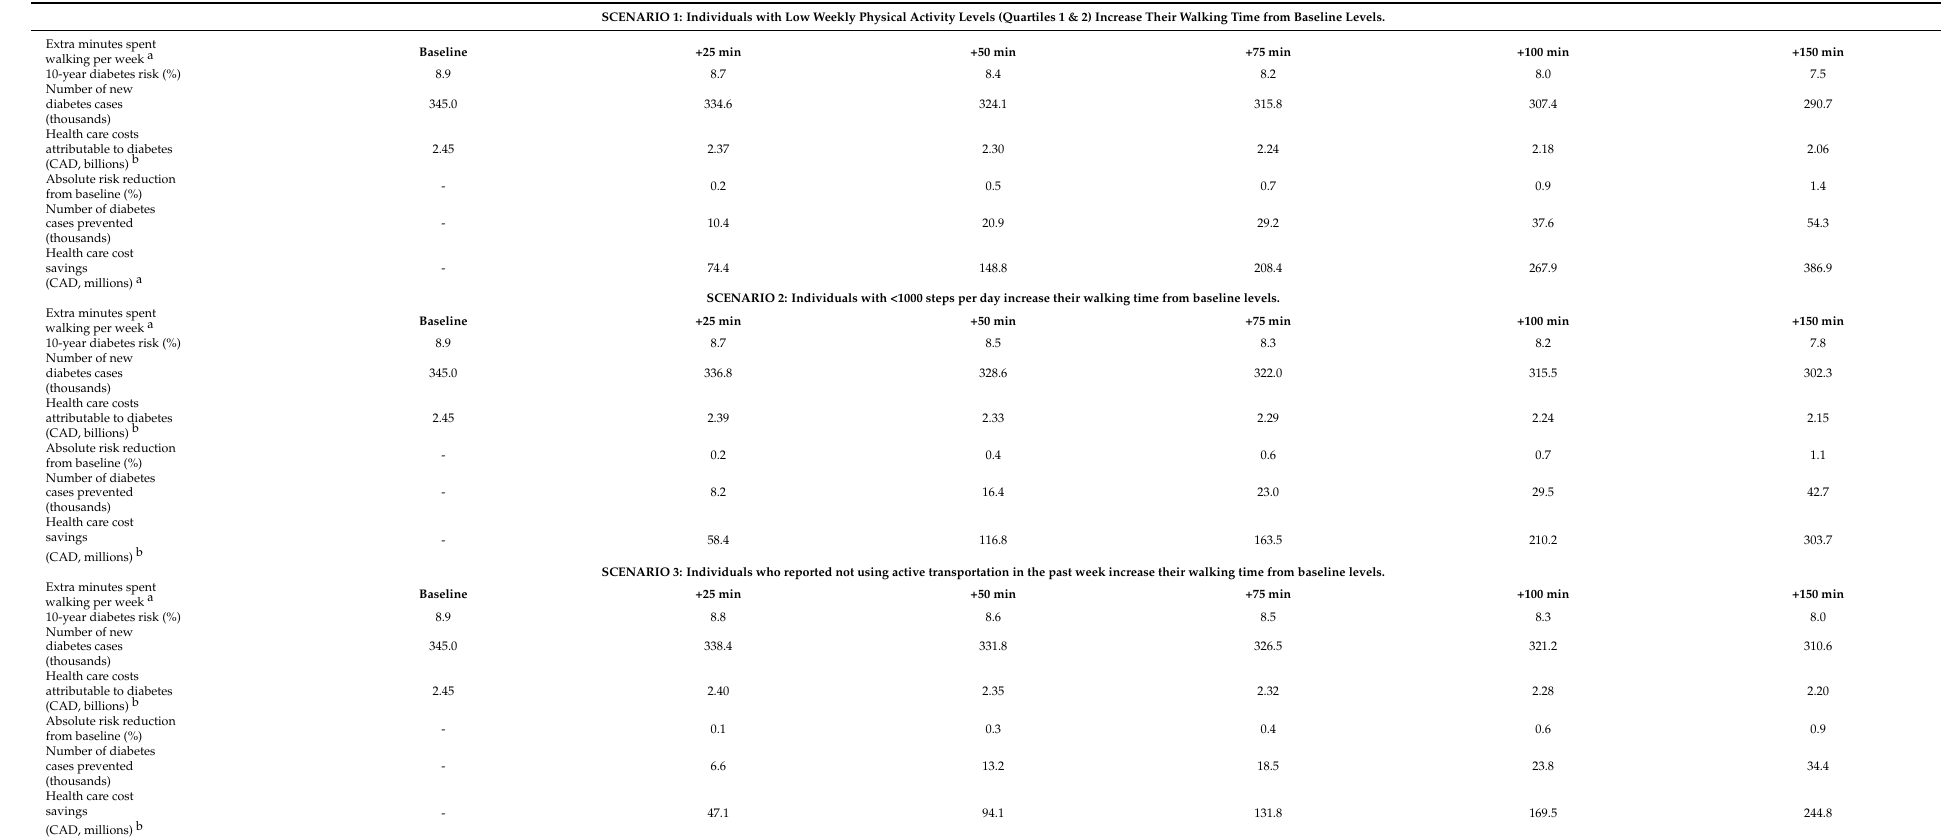
Table 3. Ten-year diabetes incidence rate, number of new diabetes cases, and costs attributable to diabetes by scenario